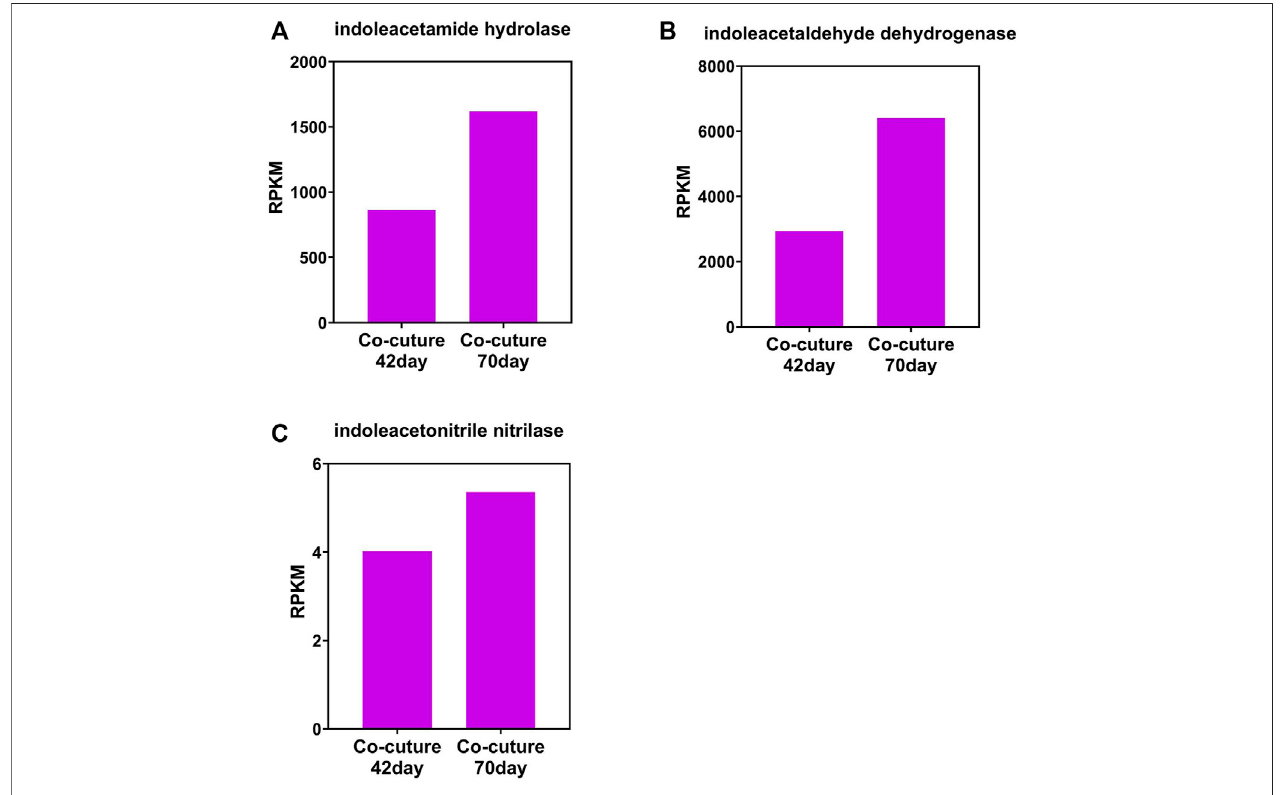
FIGURE4| GeneabundanceofbacterialIAAsynthetaseintheco-culturereactor. (A) Indoleacetamidehydrolase, (B) indoleacetaldehydedehydrogenase,and (C) indoleacetonitrile nitrilase.